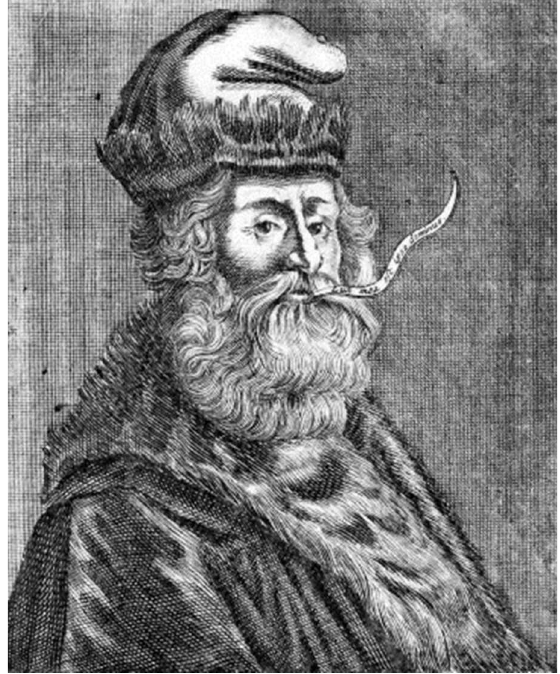
Figure 1. Ramon Llull (1232–1350) Engraving published by Friedrich